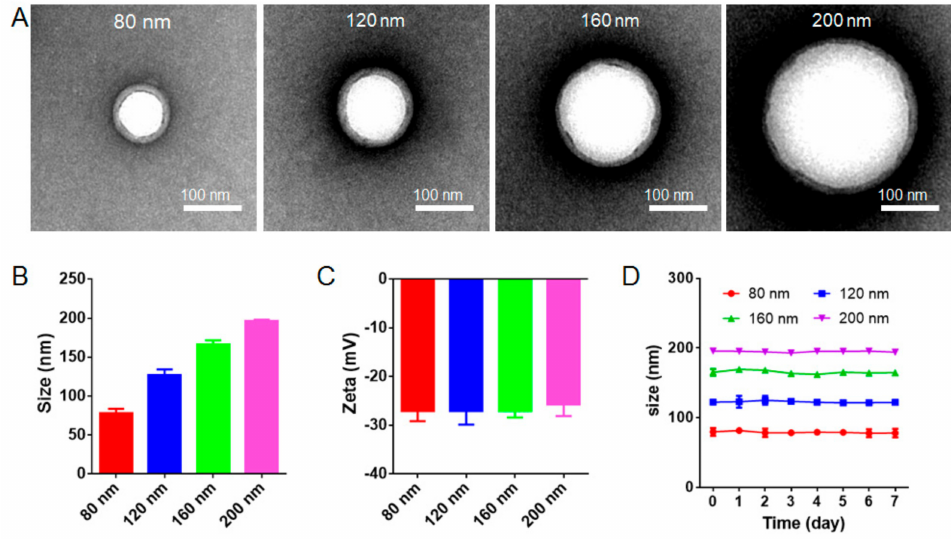
Figure 1. Characterization of red blood cell membrane-coated nanoparticles (RBC-NPs) with di ff erent diameters. ( A ) Transmission electron microscopy (TEM) images of RBC-NPs with diameters of 80 nm, 120 nm, 160 nm, and 200 nm demonstrated the core / shell structure of RBC-NPs. Scale bar = 100 nm. ( B ) Size and ( C ) surface zeta potential of RBC-NPs with four di ff erent diameters ( n = 3). ( D ) Diameter-dependent stability of di ff erent-sized RBC-NPs at 4 ◦ C for 7 days ( n = 3). All error bars represent standard error of the